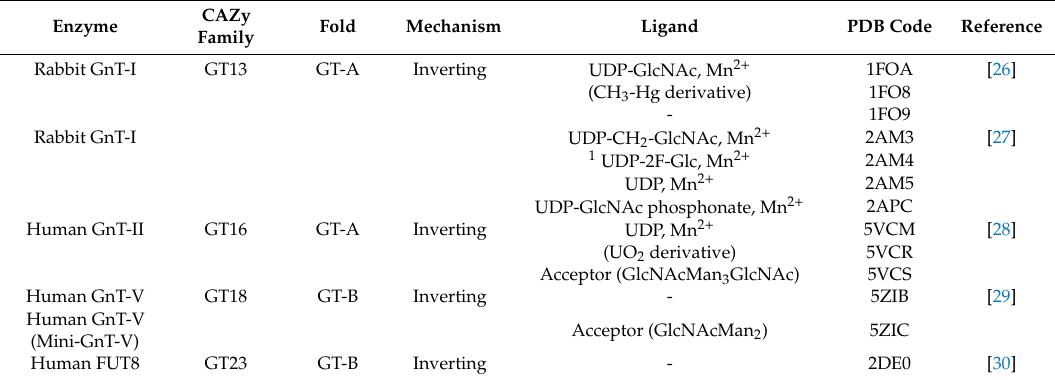
Table 1. Summary of 3D structures of glycosyltransferases involved in N -glycan maturation. All these data are deposited in Protein Data